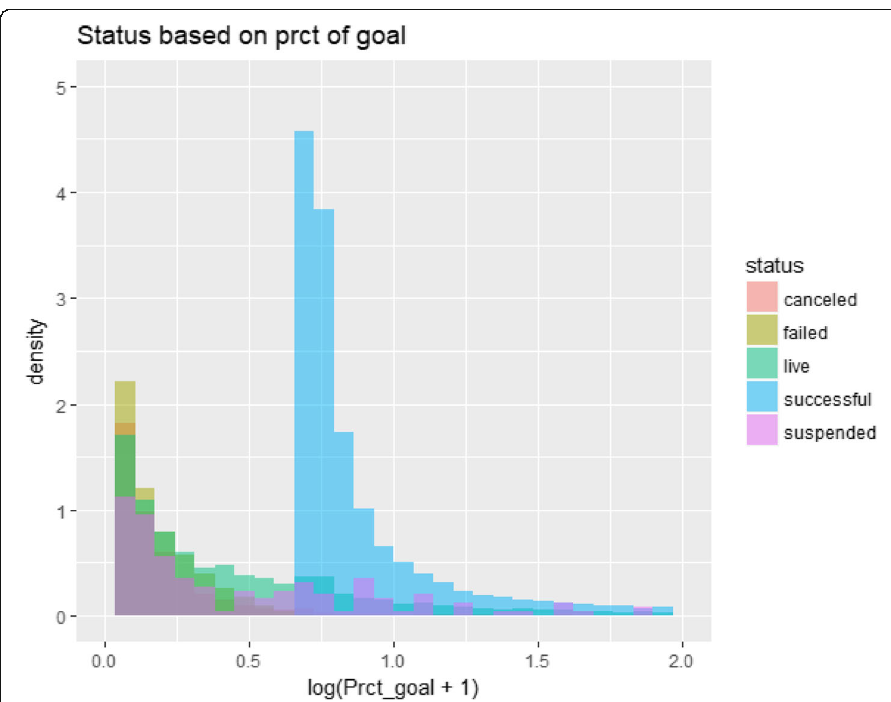
Fig. 5 Histograms of percent goal based on